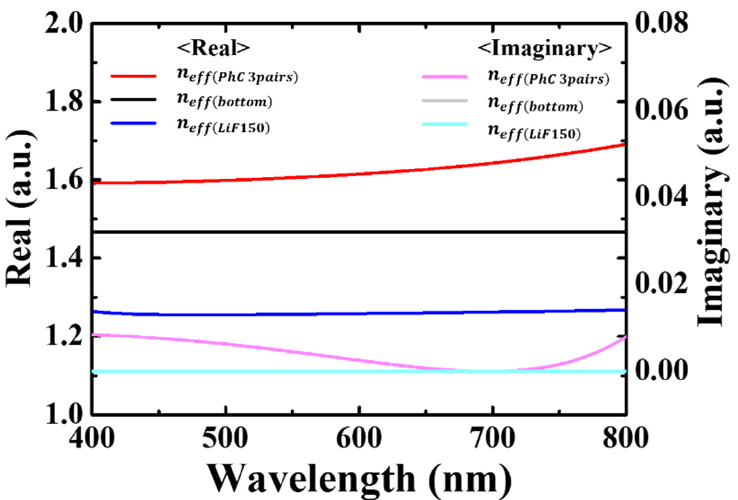
Figure 2. Refractive index of each dielectric structure: 150 nm thickness of LiF with 3 pairs of 1D PhC, 150 nm thickness of LiF, and bulk LiF.